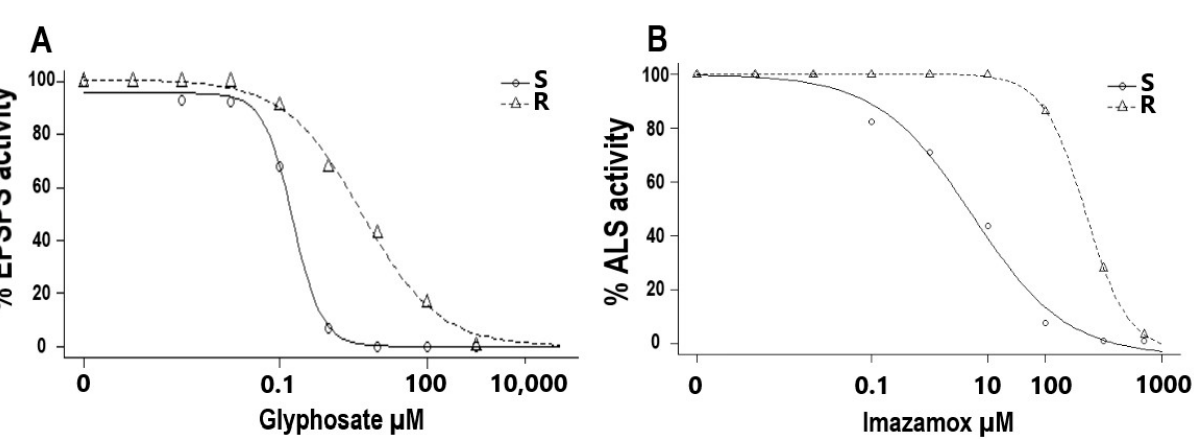
Figure 3. ( A ) EPSPS and ( B ) ALS enzyme activity expressed as a percentage of the untreated control in leaf extracts of glyphosate/imazamox ‐ susceptible and ‐ resistant Chloris radiata plants.